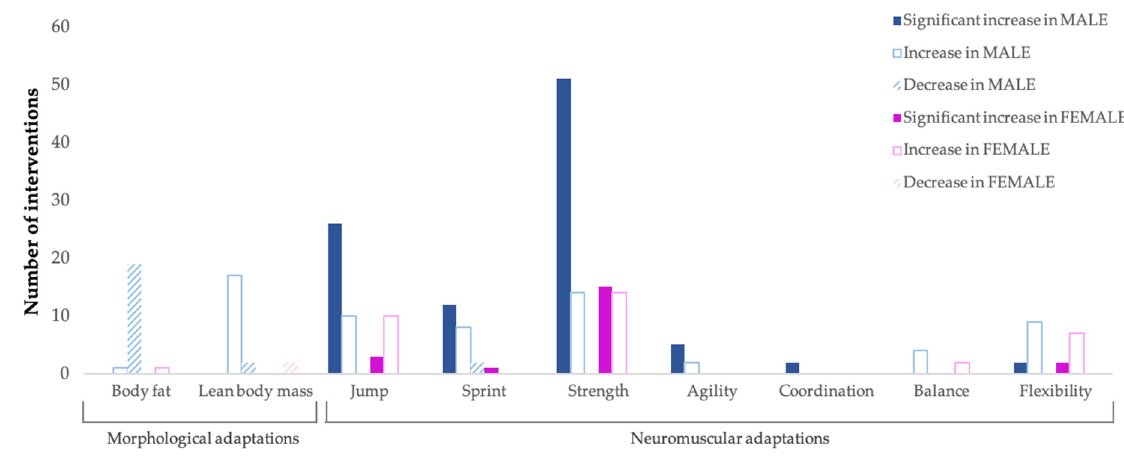
Figure 2. Gender-specific neuromuscular and morphological adaptations from STPs.